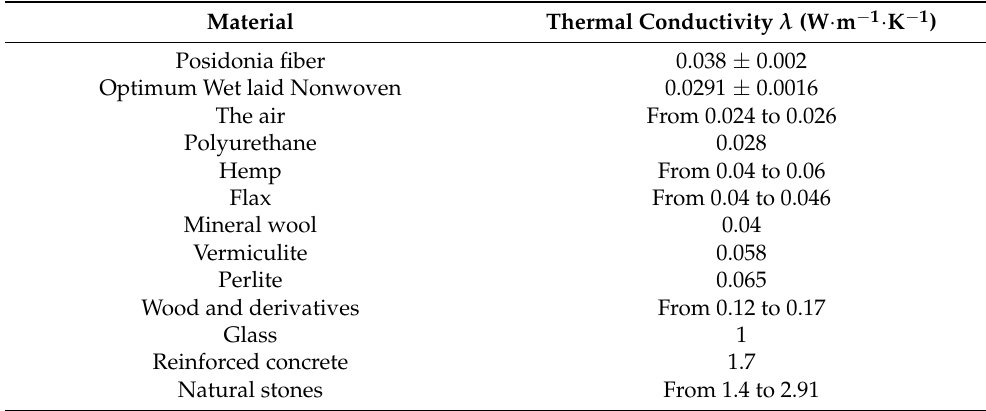
Table 7. Thermal conductivity of Posidonia fibers, nonwovens, and other materials [20–24].